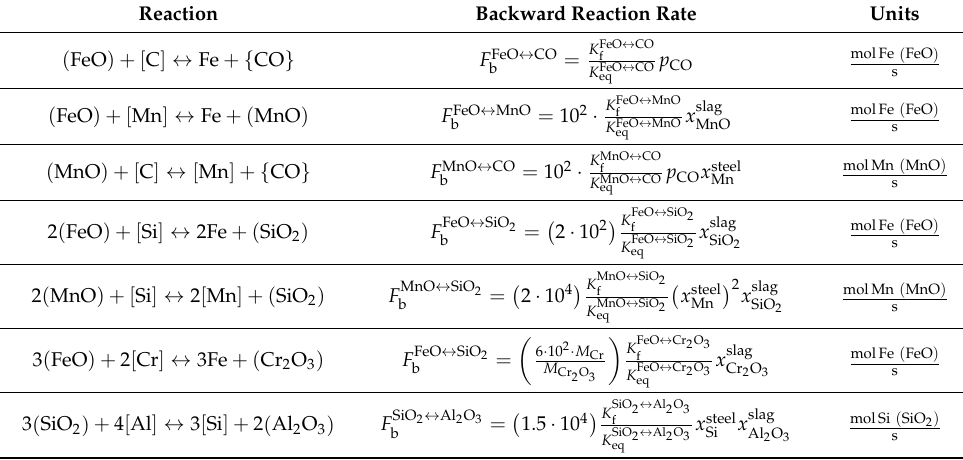
Table A4. Backward reaction rates for equilibrium reactions. x denotes mass fractions, k f refers to kinetic model constants for each reaction, p CO is the partial pressure of CO and M denotes molar masses.